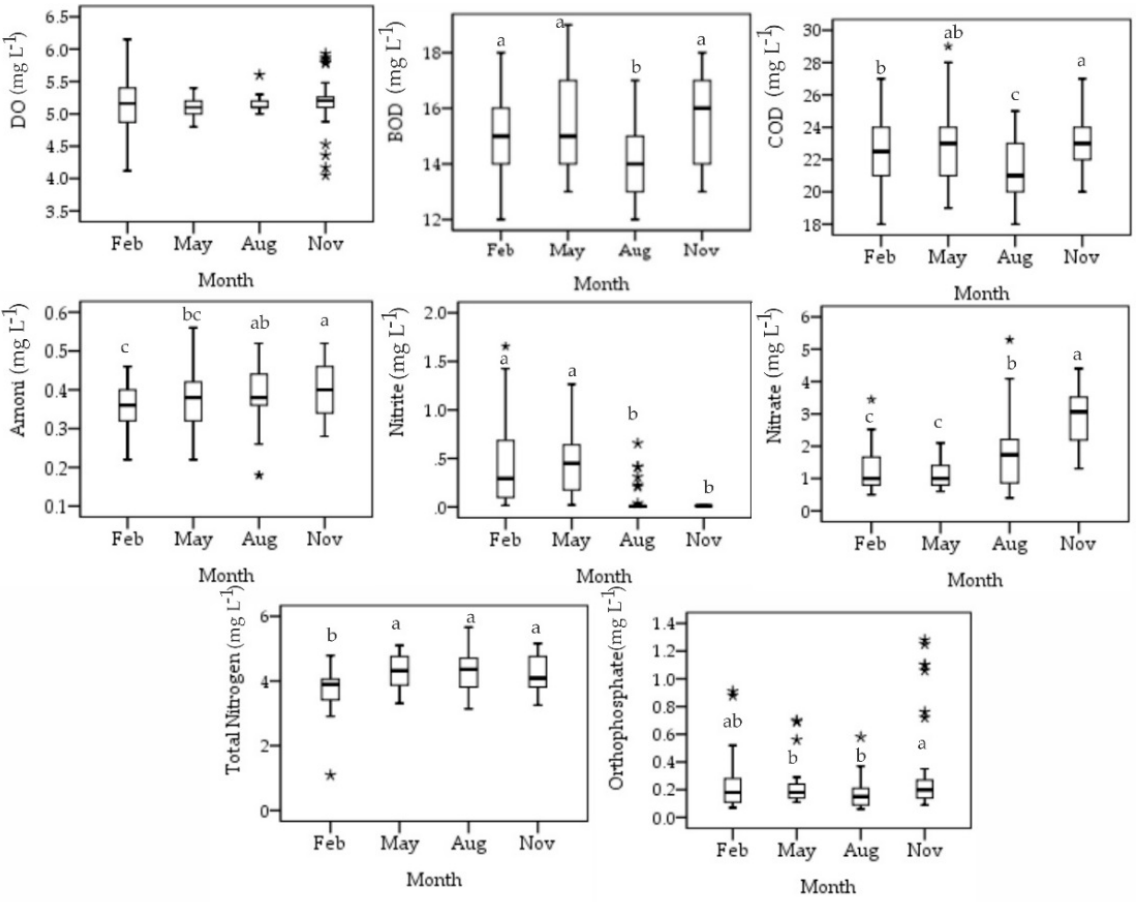
Figure 3. Oxygenation and nutrient parameters of water in Dong Thap province in 2019. Note: * the highest/lowest values of variation; Letters a, b, c indicated significant differences at a significance level of 5%; in contrast, the same letters have no statistically significant difference.